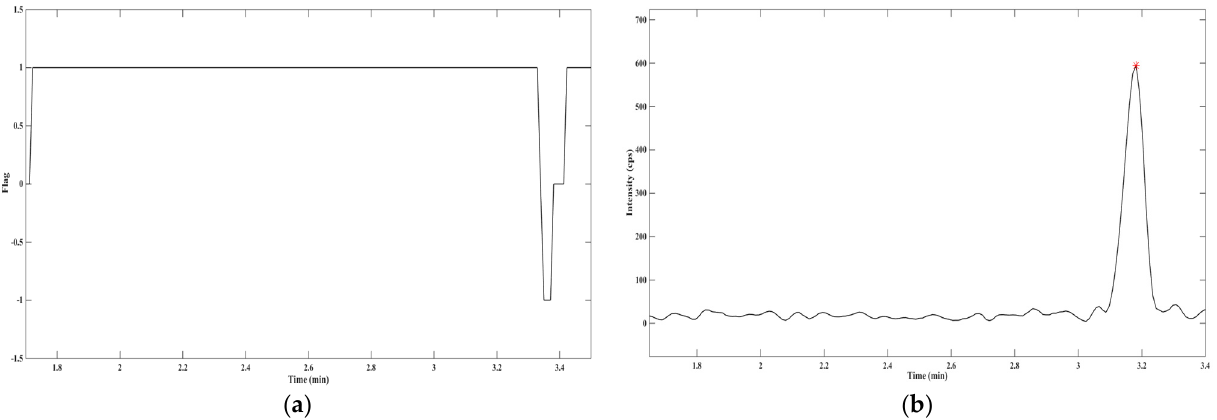
Figure 2. An example of the signal classification results of the extracted ion chromatogram of VD2 in a 20 ng/mL standard. ( a ) The results of the signal classification; ( b ) the corresponding chromatographic peak information; the red * marks the chromatographic peak location identified by the algorithm in this paper.